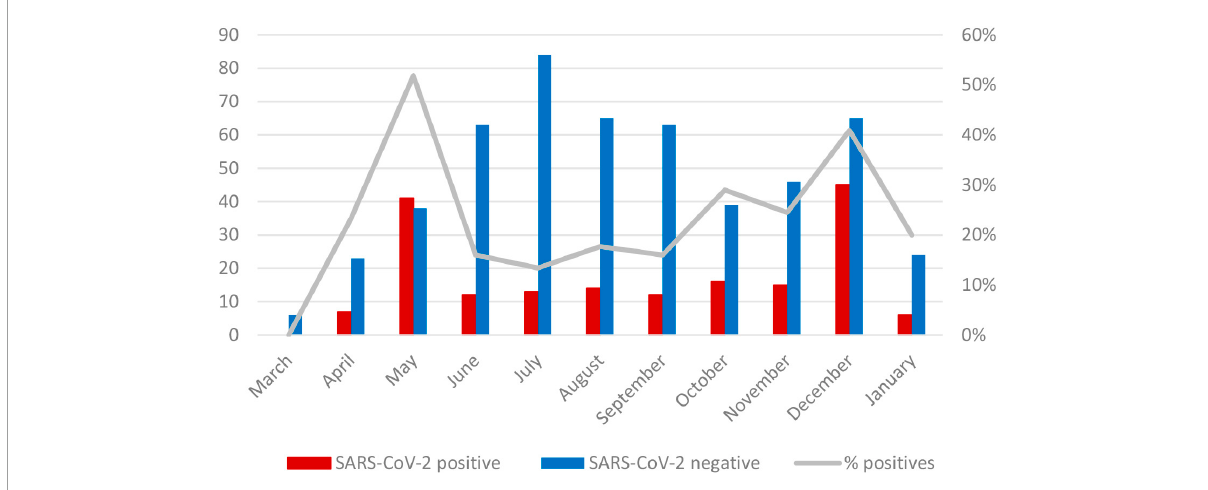
FIGURE1 SARS-CoV-2 positive cases and positivity rate from 21 March 2020, to 13 January 2021, Pediatric Hospital National Medical Center, Mexico